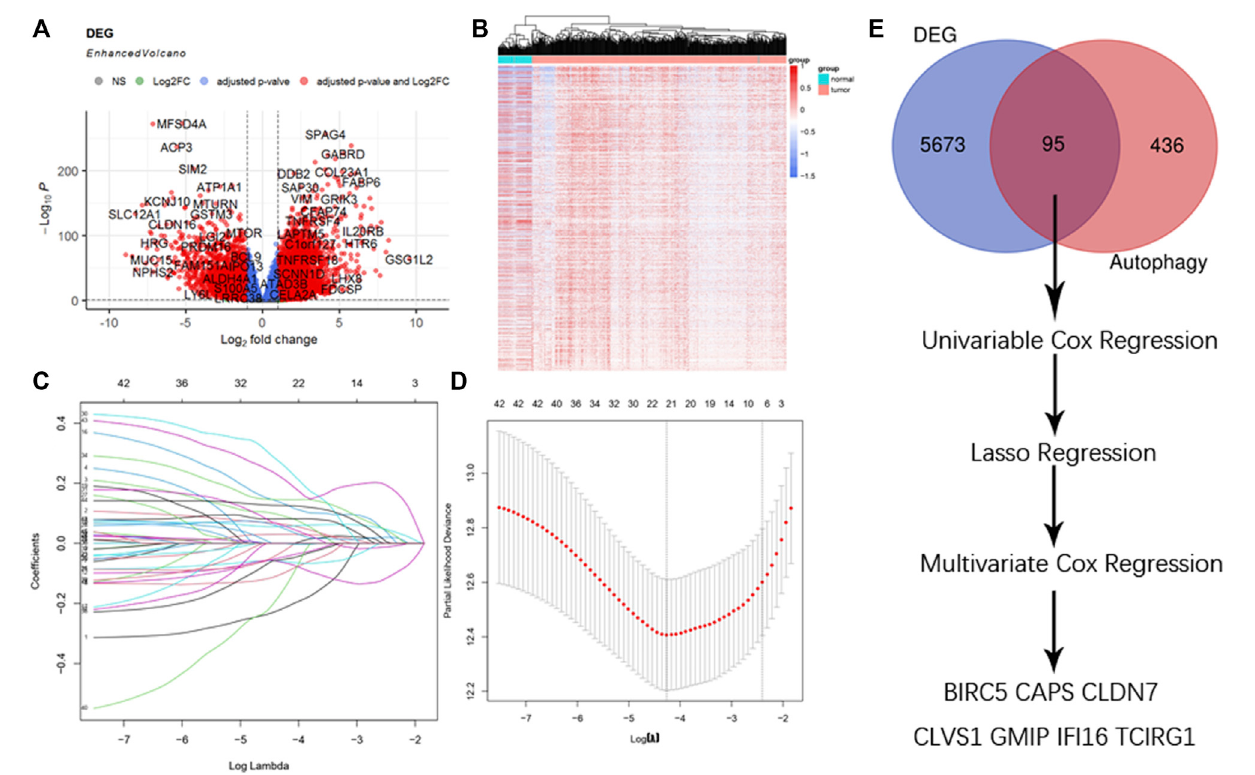
FIGURE 1 | Selection ofDEGs. (A) Enhanced volcano plotofDEGswhencomparing ccRCC withnormal tissue. Red nodesrepresented geneswith|log 2 FC| ≥ 1 and adjusted p < 0.05, bluenodes represented geneswithadjusted p < 0.05only, and greynodes represented genes that wereneither eligibleinconditions ofadjusted p value nor|log 2 FC|. (B) HeatmapofDEGsinccRCC. (C) Lassocoef fi cientspro fi lesof95genessigni fi cantinunivariatecoxregression. (D) Lassoregressionobtained21prognostic genesusingminimumlambdavalue. (E) SelectingprocedureofDEGs,venngramshowed95genesintheintersectionof5,768DEGsand531ATGs.Thesegenesthen underwent univariate cox regression, lasso cox regression, multivariate cox regression, and fi nally 7 DEGs were selected to construct the risk score formula.